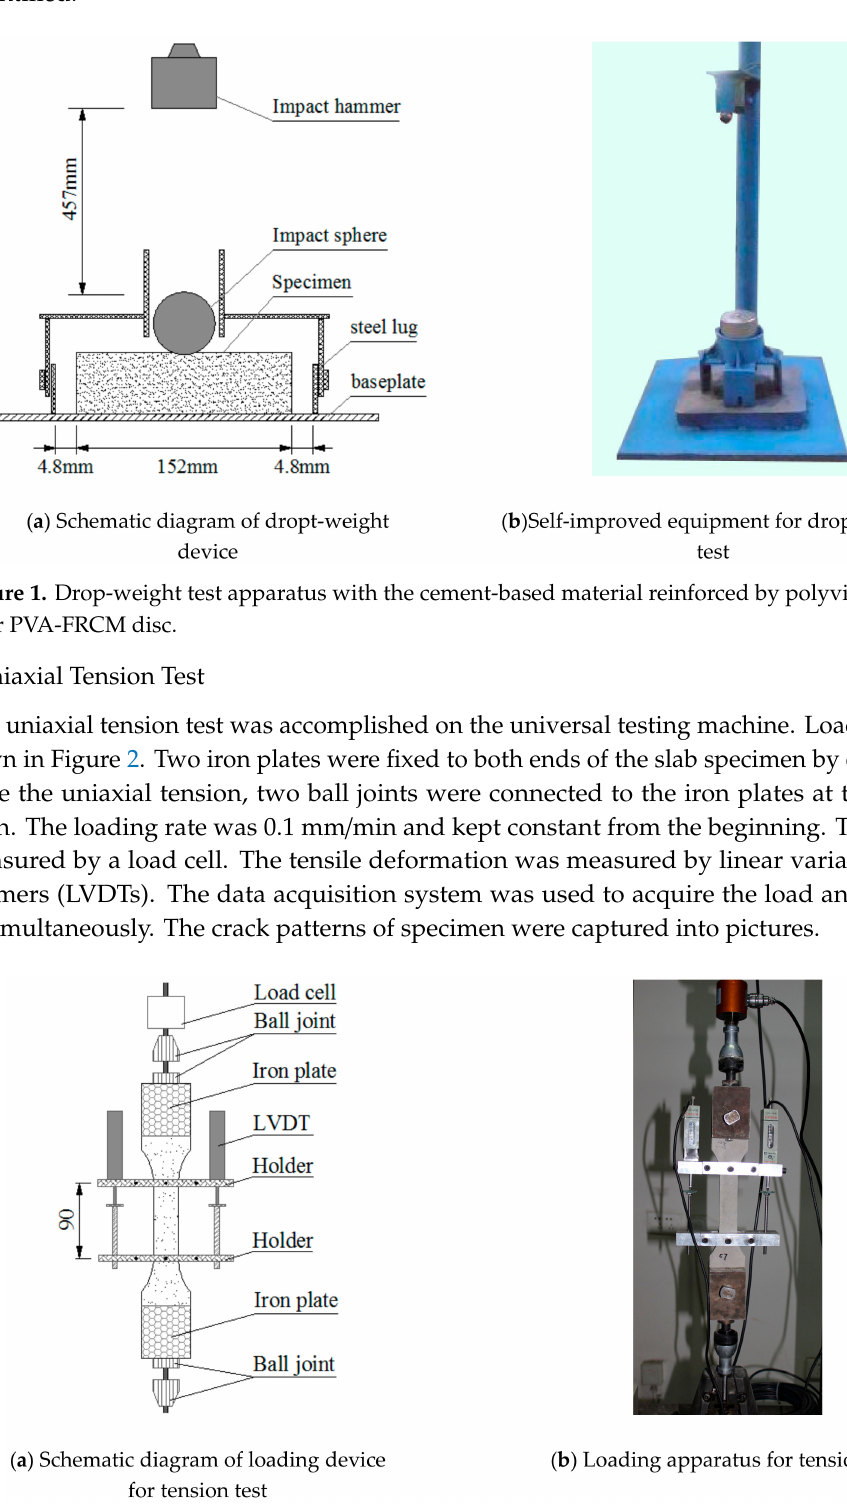
Figure 2. Specimen and loading apparatus for tension